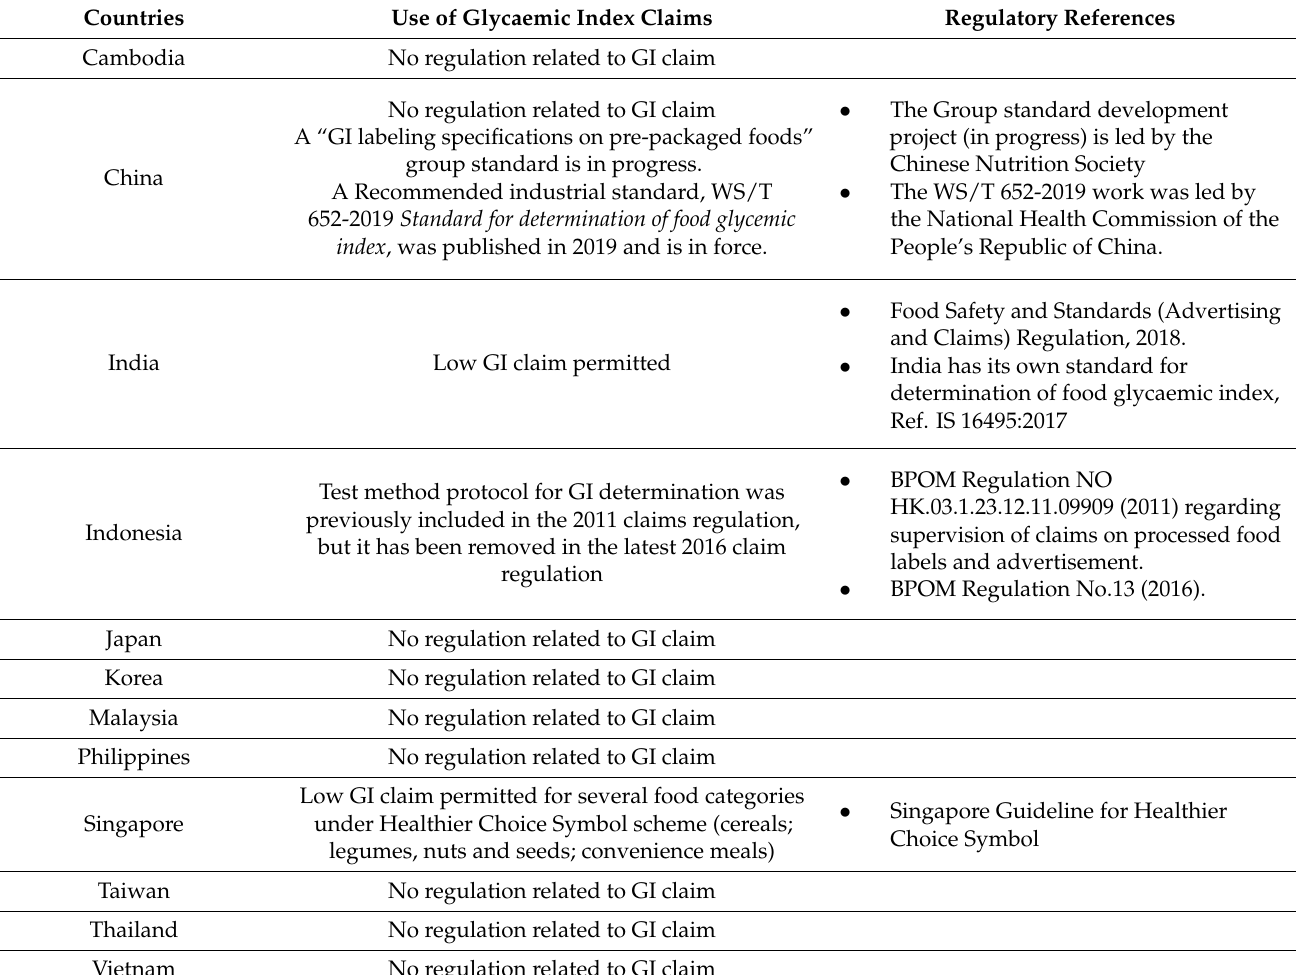
Table 3. Summary of low GI claims in